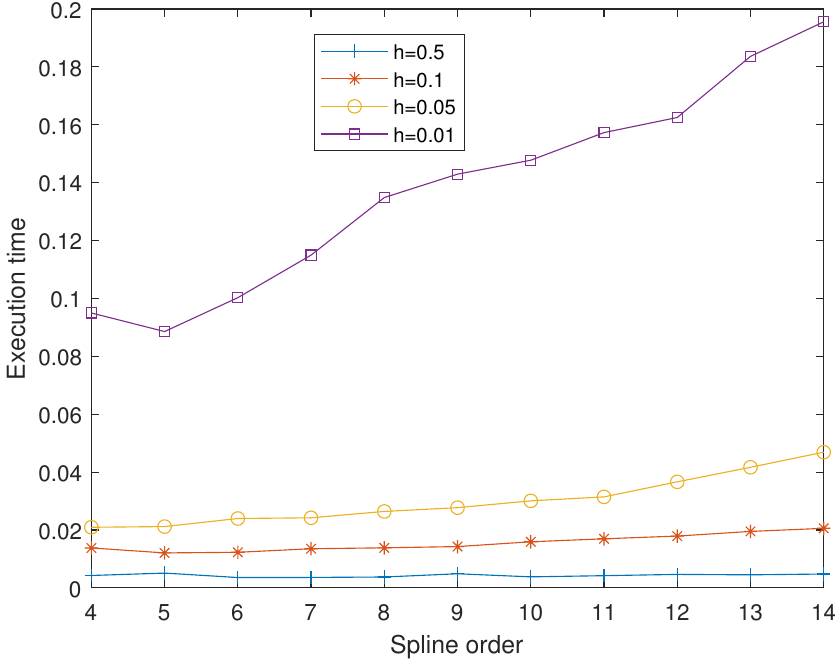
Figure 6. Execution time, for the nonlinear matrix problem (35), depending on the spline